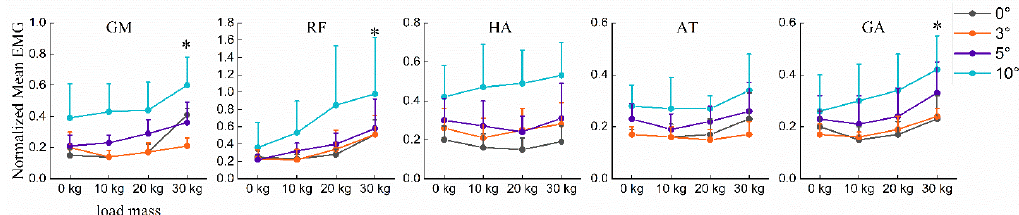
Figure 4. Mean EMG signals for muscles while walking across all grades with different backpack loads during one gait from right heel strike to the next right heel strike, normalized to the mean activity during level walking without backpack loads. * Representing the mean EMG was significantly different from walking without backpack loads across all the grades, according to post hoc comparisons with a Bonferroni adjusted level of significance ( p < 0.0072). The line in dark gray represented the normalized mean EMG of each muscle with different load masses during level walking. The line in orange represented the normalized mean EMG of each muscle with different load masses during slope walking at grade 3°. The line in purple represented the normalized mean EMG of each muscle with different load masses during slope walking at grade 5°. The line in blue represented the normalized mean EMG of each muscle with different load masses during slope walking at grade 10°.